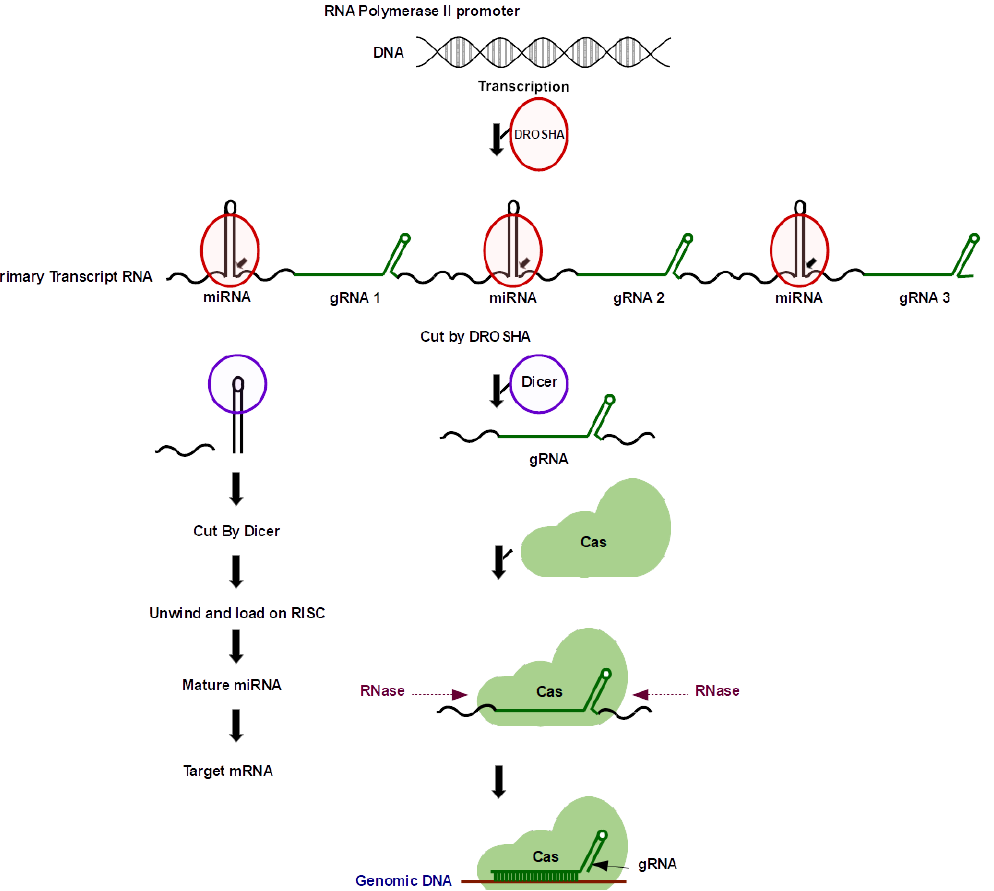
Figure 6. Drosha based approach for multiplex gene editing. In this system, gRNAs and miRNAs are cloned in a tandem array. Dicer cleaves the miRNA ends and thereby separating gRNAs also. The pathway on the left explains the general scheme for miRNA mediated mRNA targeting, and the one on right side explains miRNA-based gRNA multiplexing system. Abbreviations. miRNA: micro RNA; gRNA: guide RNA; RISC: RNA induced gene silencing complex; Cas9: CRISPR associated protein 9; RNase: ribonuclease; sgRNA: single guide RNA. Here, sgRNA and gRNA imply the same entity.